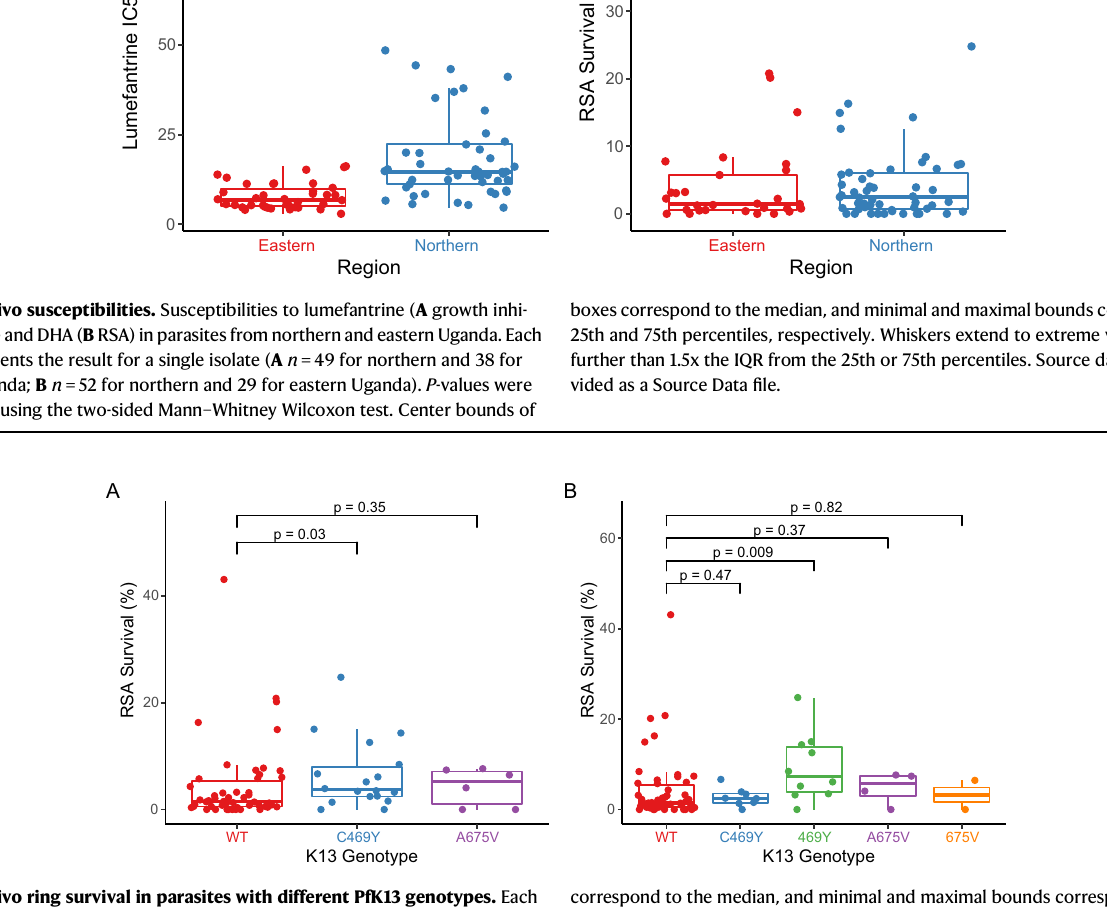
correspond to the median, and minimal and maximal bounds correspond to 25th and 75th percentiles, respectively. Whiskers extend to extreme values no further than 1.5x the IQR from the 25th or 75th percentiles. WT, wild type. Source data are provided as a Source Data fi